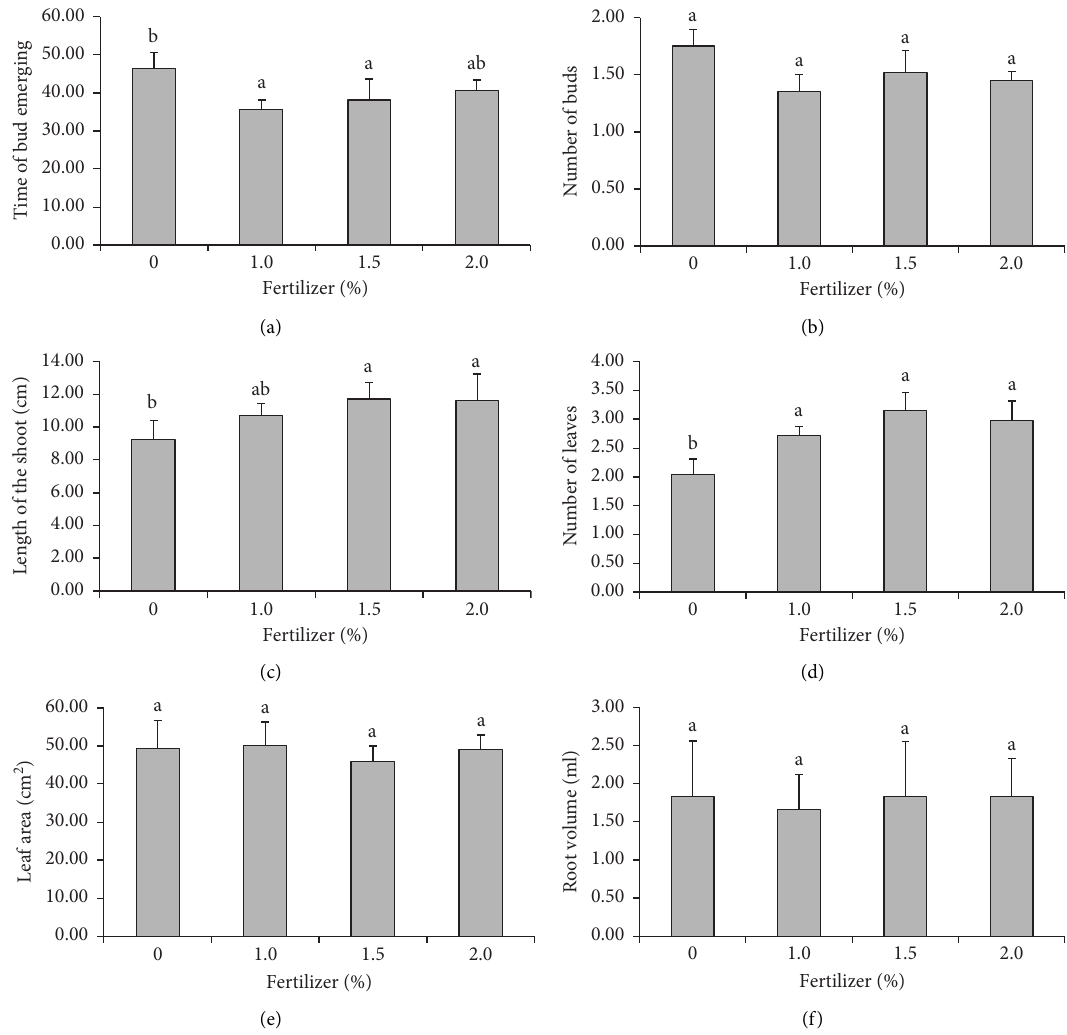
Figure 4: Effect of foliar fertilizer (FF) application on (a) emergence time of the shoot, (b) number of shoots, (c) shoot length, (d) the number of leaves, (e) leaf area, and (f) root volume of black pepper seedlings (after 8 weeks of planting). Different letters indicate significant differences among treatments as determined by Tukey’s HSD test at the p < 0 . 05 level. Vertical bars represent